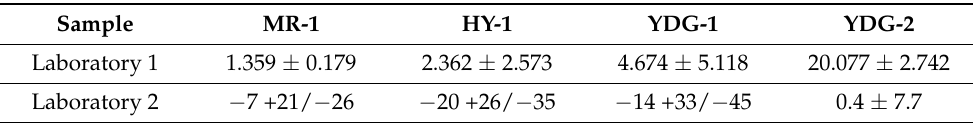
Table 1. Comparison of the raw U–Th ages of four split samples provided by two laboratories: all ages in ka. Sample MR-1 HY-1